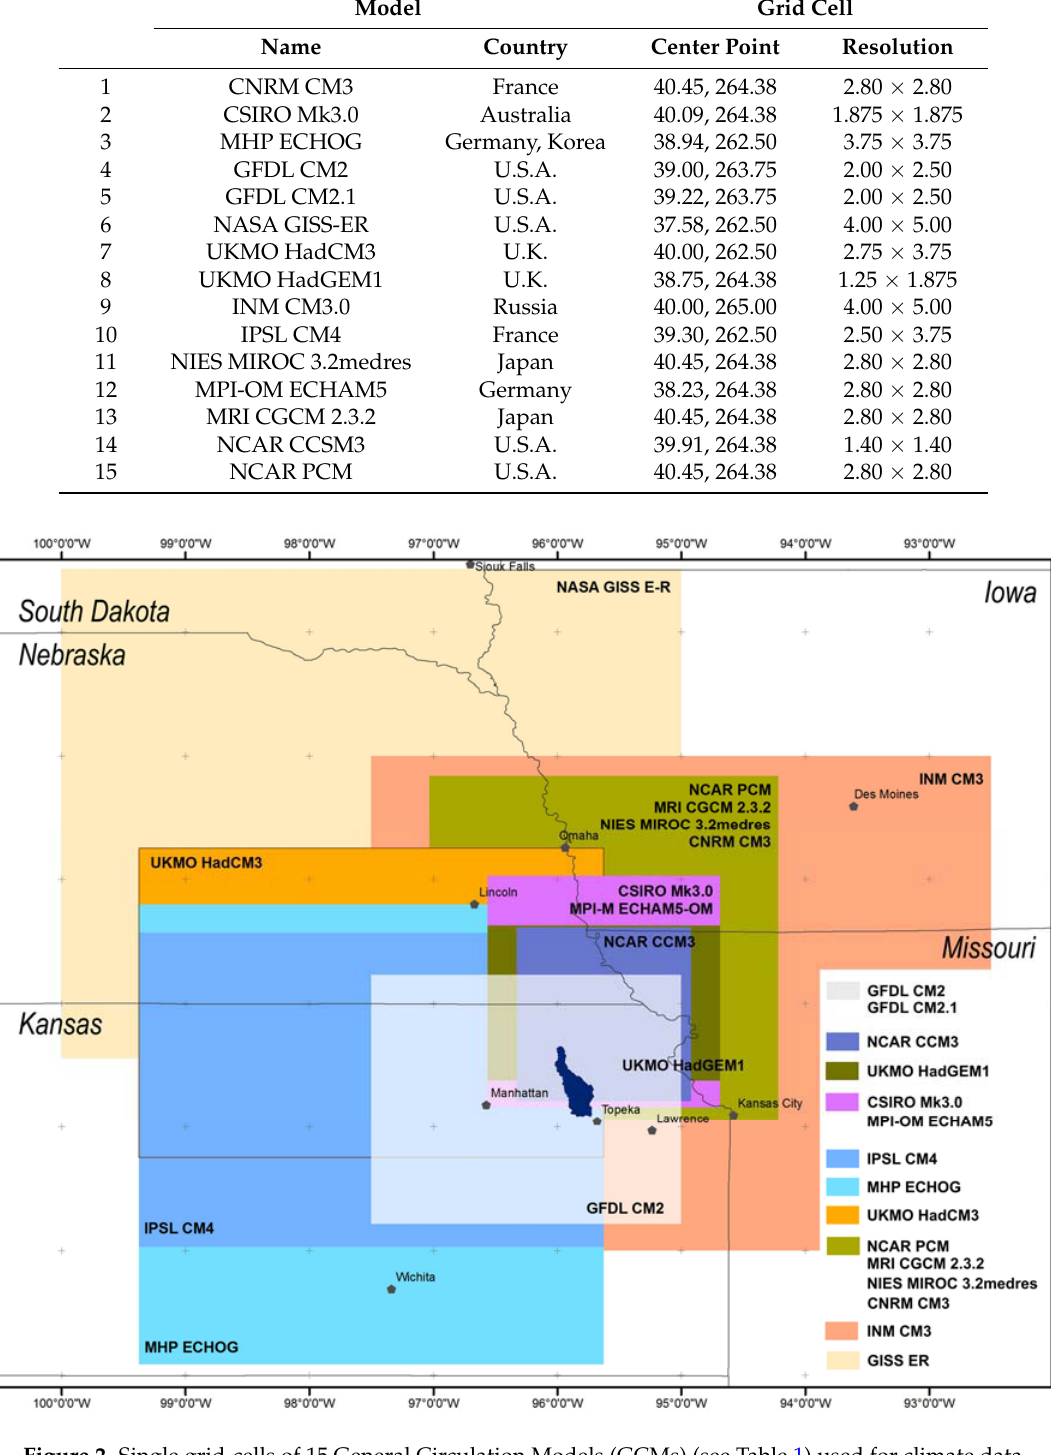
Table 1. 15 CMIP3 general circulation models [1], grid-cell resolution (degrees) and center point (latitude, longitude).